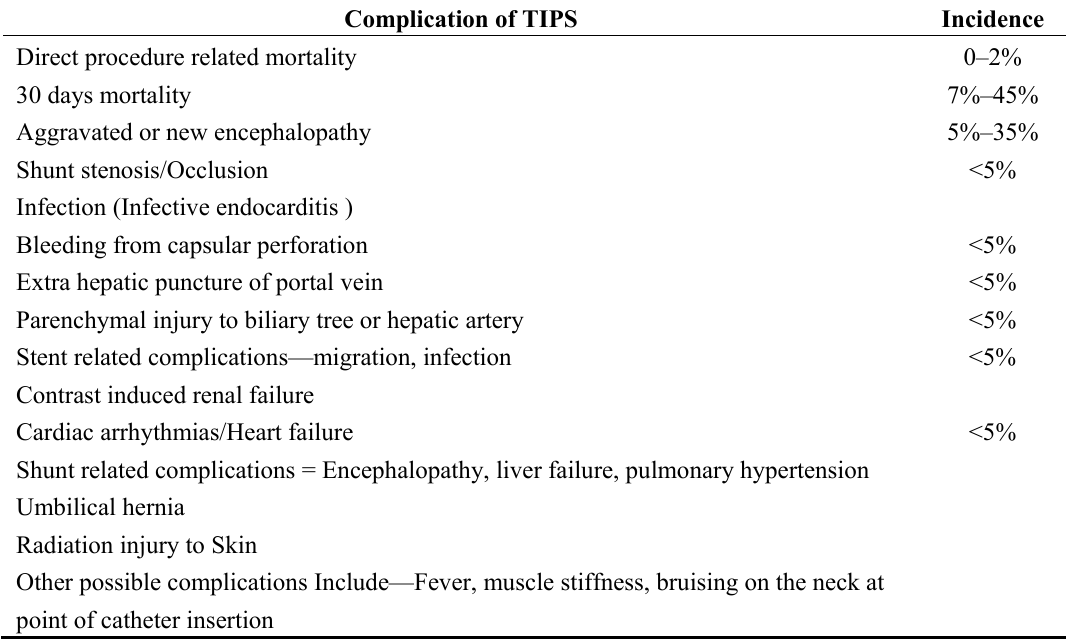
Table 1. Reported complications of TIPS (transjugular intrahepatic portosystemic shunt)